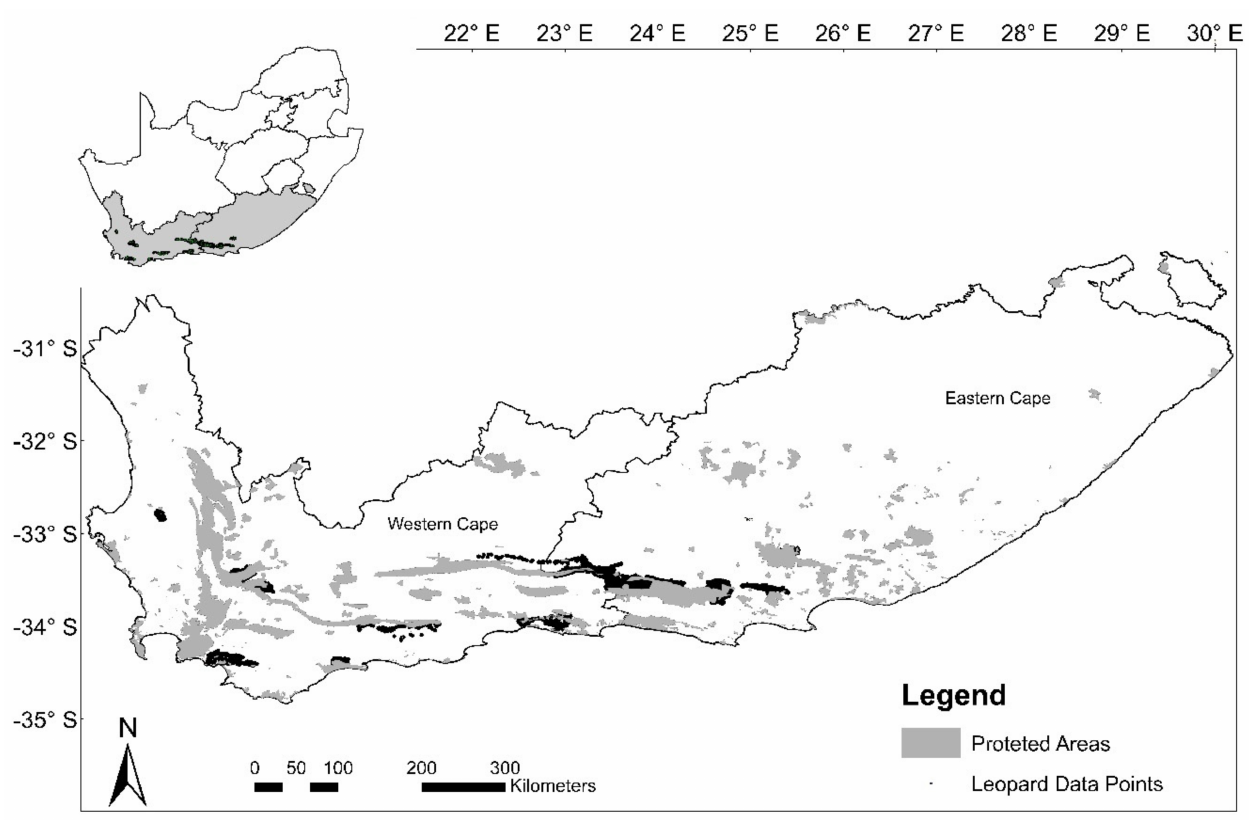
Figure 1. Study area and distribution of leopard occurrence data used to predict leopard habitat distribution models. The insert indicates the location of the study within South